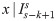
Empirical prediction accuracy.We compare the APE metric (dotted blue, left y axis) to the percentage of true incidence values, Is+1, which fall outside the 95% prediction intervals of x|Is-k+1s (dotted red, right y axis) across the window search space k. The dashed line gives k* (black) and k = 7 (grey). The top graph presents results for the influenza 1918 dataset, while the bottom one is for SARS 2003 data. We find that heuristic weekly windows lead to appreciably larger forecasting error than the APE selections.